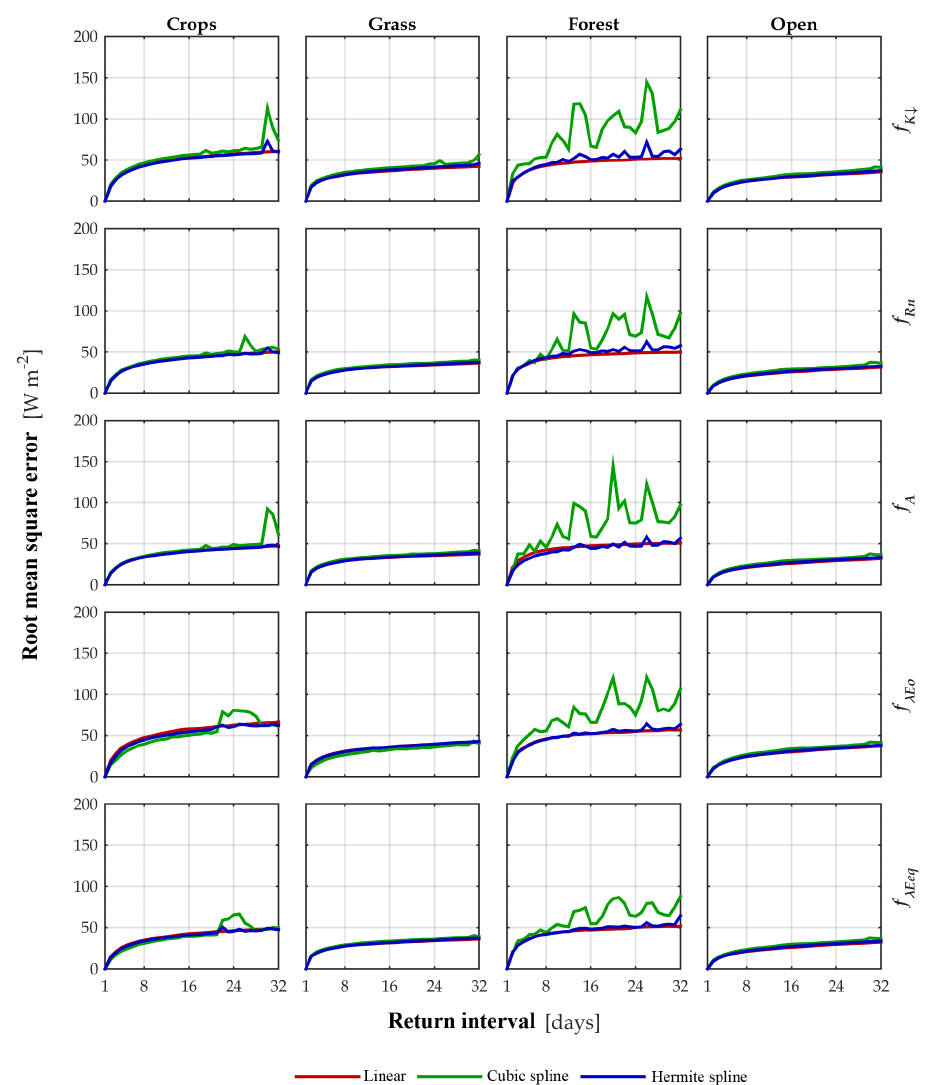
Figure 7. The root mean square error (RMSE) of the latent heat flux derived from each of the scaled quantities is shown for each land cover type and interpolation